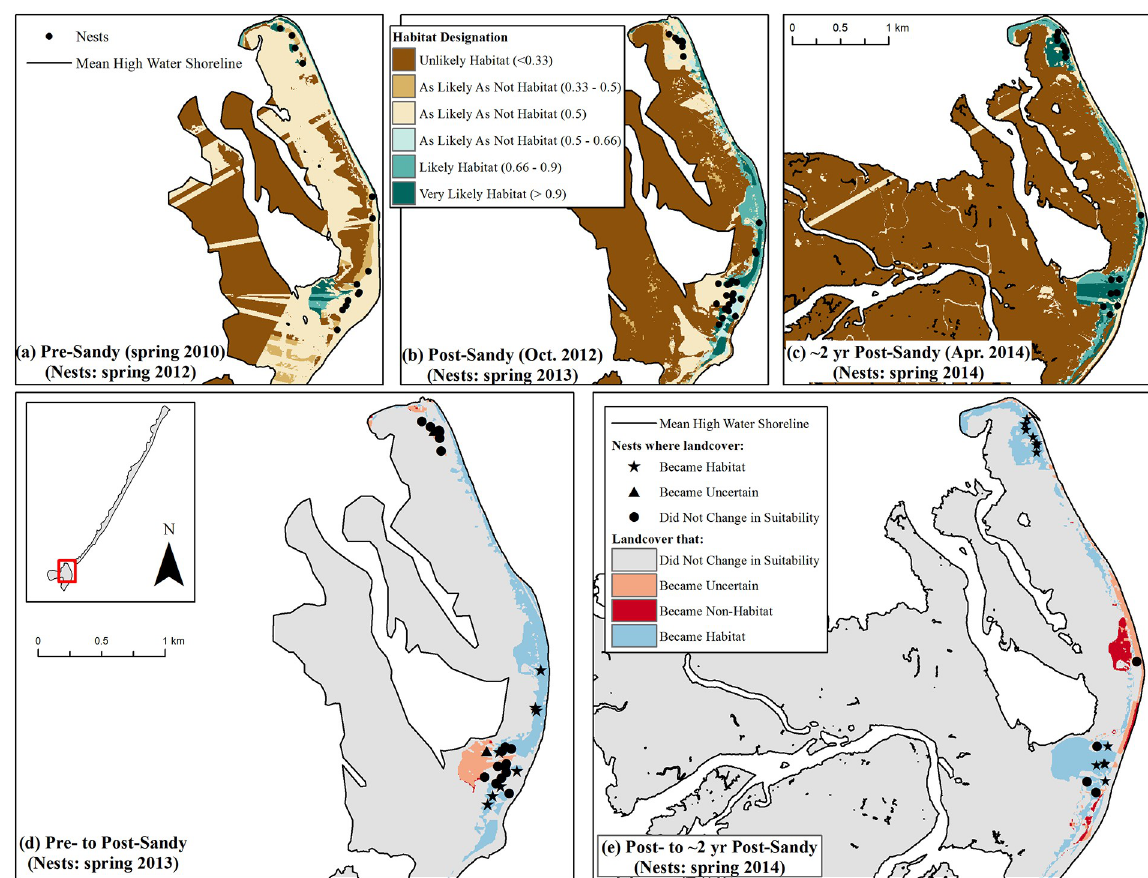
Fig 6. Examples of habitat change before Hurricane Sandy, immediately following Sandy, and ca. 2 years post-Sandy in a portion of the Little Beach Unit of the Edwin B. Forsythe National Wildlife Refuge on Pullen Island, New Jersey. Maps (a)-(c) show habitat in the year corresponding with the aerial imagery used for analysis, with piping plover nest points corresponding to the breeding season for which habitat was available 1 . Map (d) shows changes in habitat that ostensibly resulted from Hurricane Sandy, while map (e) shows changes in habitat since the hurricane occurred 2 . 1 Nest points contributed by [67]. 2 See footnotes accompanying Fig